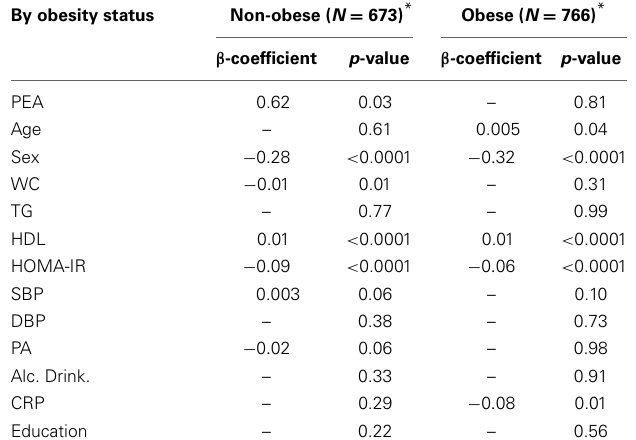
Table 3 | Linear multivariable association between adiponectin and proportion of European